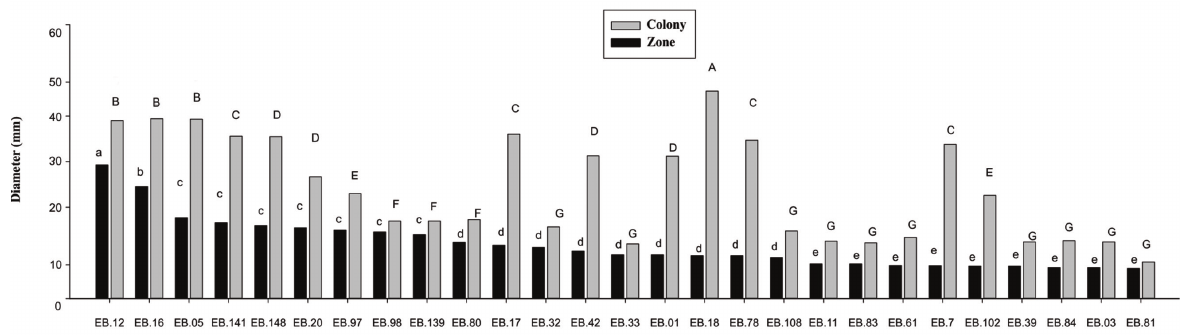
Figure 1 - Average colony (colony Ø) and phosphate solubilization zone (zone Ø) diameters in NBRIP medium supplemented with tricalcium phosphate [Ca (PO ) ] for endophytic bacteria isolated from “Prata Anã” banana tree roots. Data are in mm. (Vertical 3 4 2 bars represent the standard error). The means followed by the same upper and lower case letters indicate they belong to the same group through the Scott-Knott test at a significance level at P <